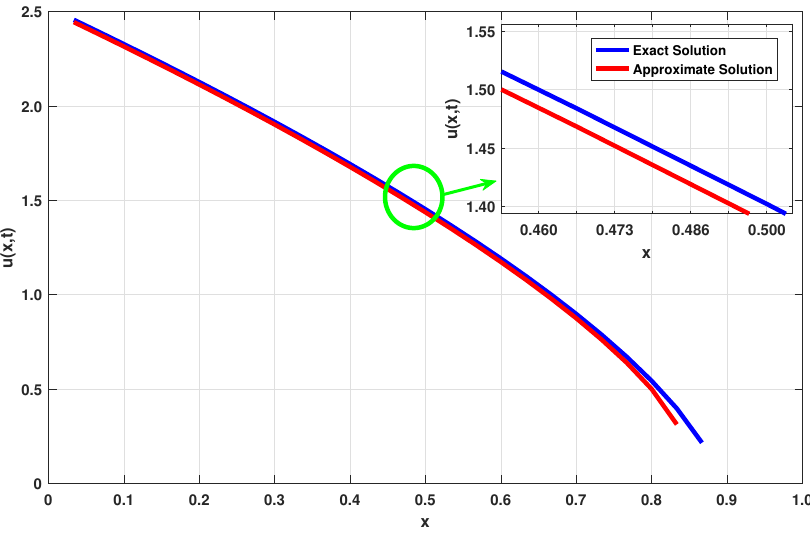
Fig. 1 Comparison of the exact and approximate solution for linearization 2 at h = 0 . 01